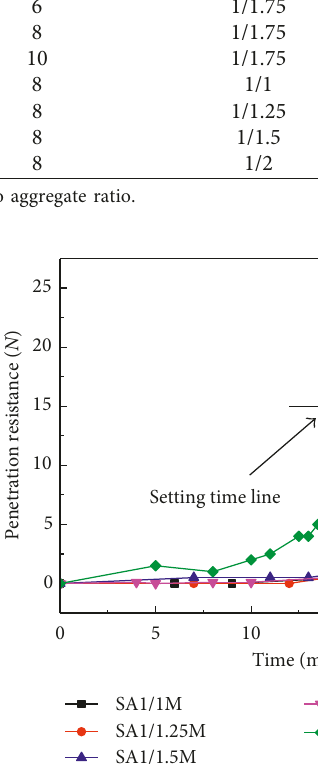
Figure 2: The effect of slag to aggregate ratios on the setting time of AAS